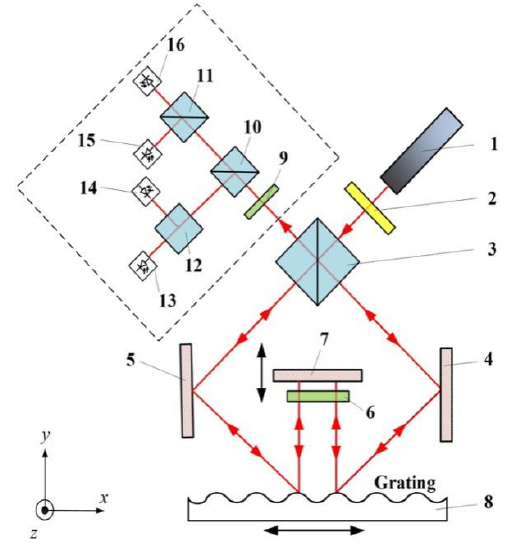
Figure 5. Grating interferometer system for evaluation of EMLMA performance. 1. Laser source; 2. 1/2 wave plate; 3,11,12. PBS; 4,5,7. Reflection mirrors; 6,9. 1/4 wave plate; 8. Measurement grating; 10. NPBS; 13,14,15,16. Photodetectors.